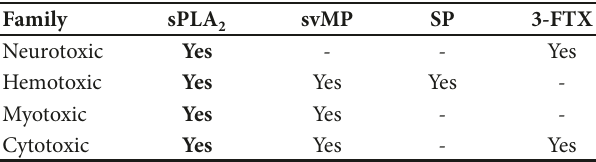
Table 2: Generic pathogenesis of major toxins in snake